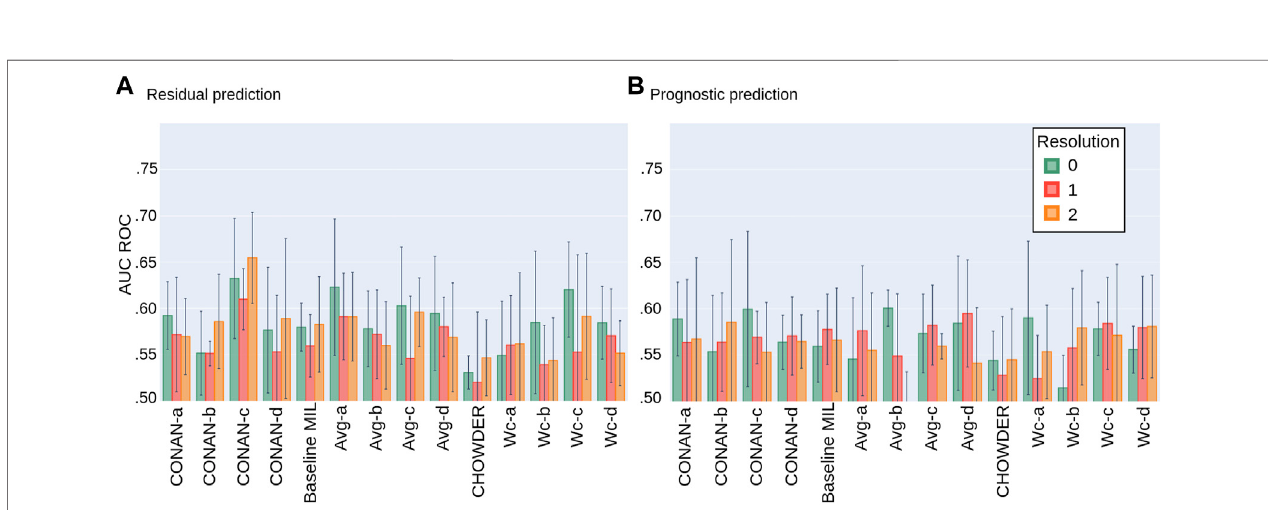
FIGURE 8 | Average AUC ROC performance with standard deviation on fi ve fold NECV on the task of predicting: (A) residual cancer and (B) patient prognostic in TNBC.